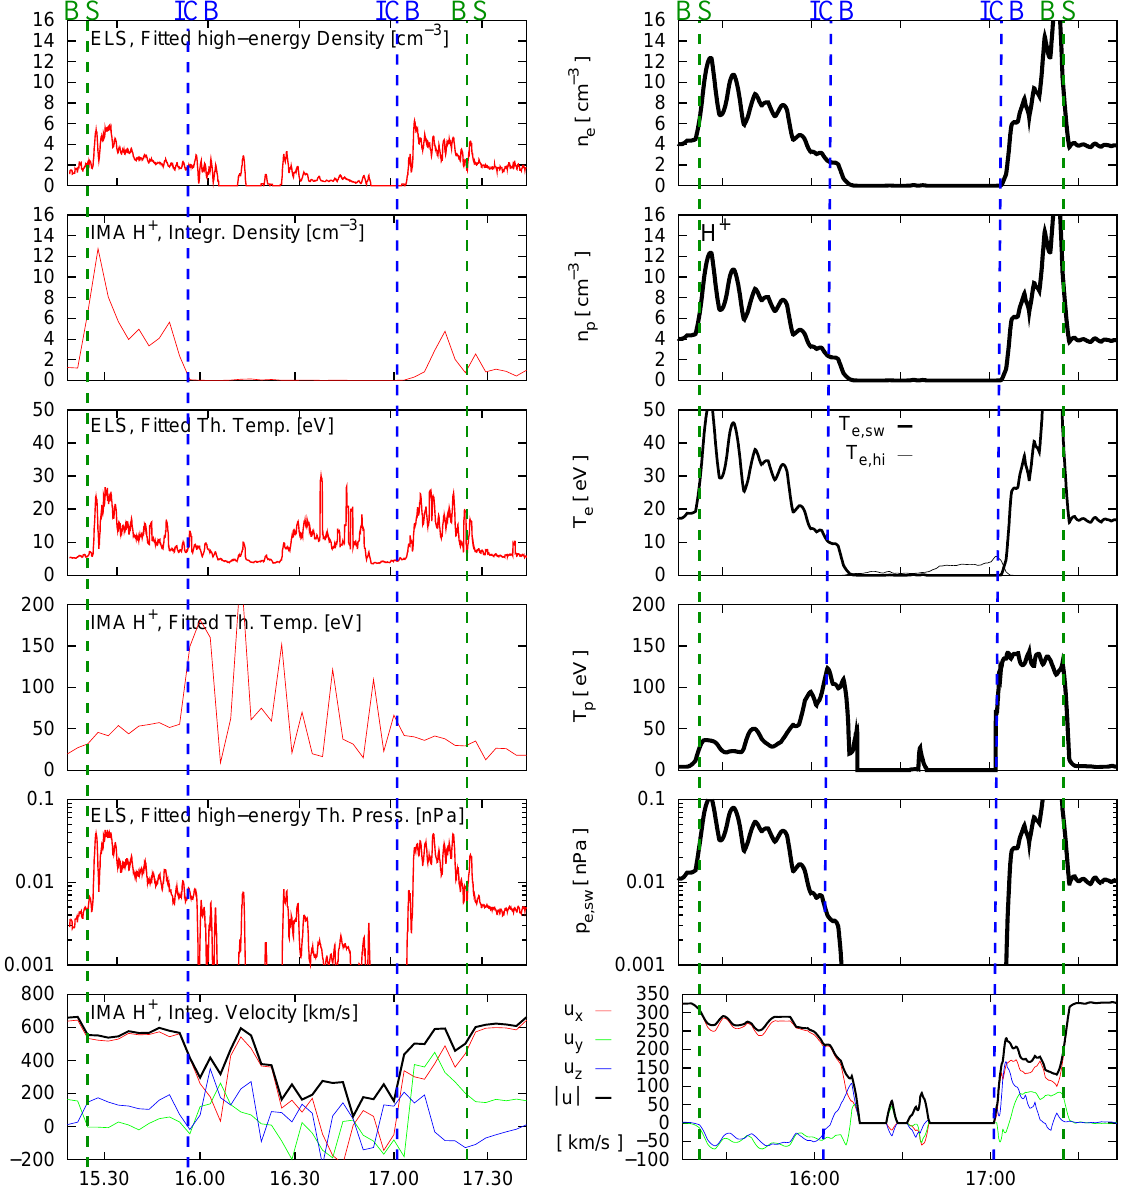
Fig. 8. Smoothed ELS und IMA data at the left hand side is represented in direct comparison with results from a hybrid simulation on the right hand side. The simulation data were extracted exactly for the MEX trajectory. Additionally positions of the bow shock and of the ICB/MPB are marked in green and blue dashed lines. Displayed are from top to bottom: the electron and proton density, as well as the temperature, the thermal electron pressure and the components as well as the total value of the proton velocity. The simulation results show a good qualitative agreement with data obtained from ASPERA-3/MEX both at the developing and at the positions of the